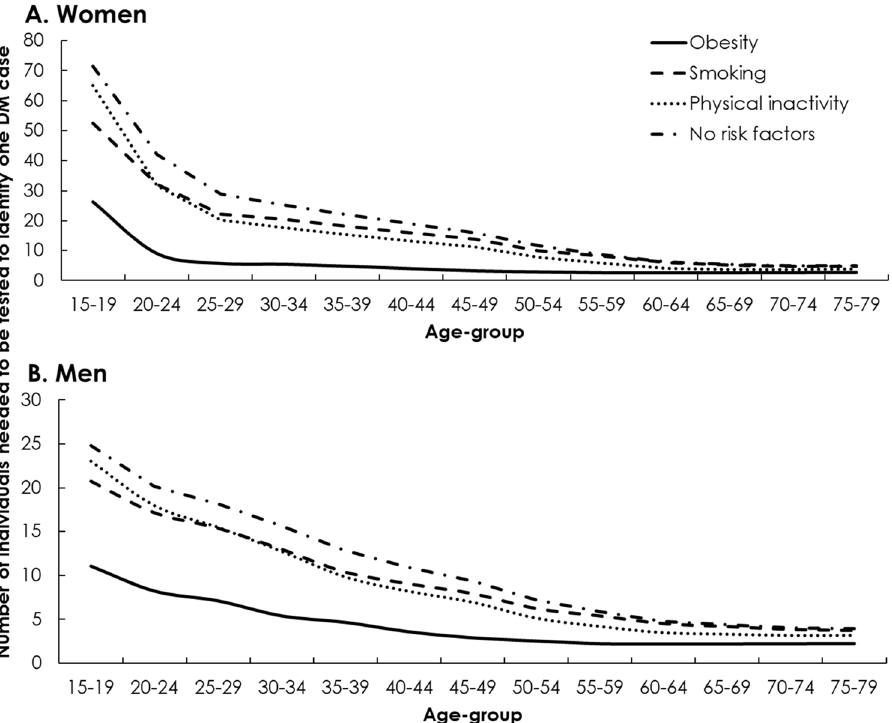
Figure 1. Yields of a screening program for diabetes mellitus (DM) targeting different subpopulation strata of ( A ) women and ( B ) men in 2020. The yield is defined as the number of individuals needed to be screened for DM to identify one DM case. The targeted subpopulations are stratified by age-group and obesity, smoking, and physical inactivity